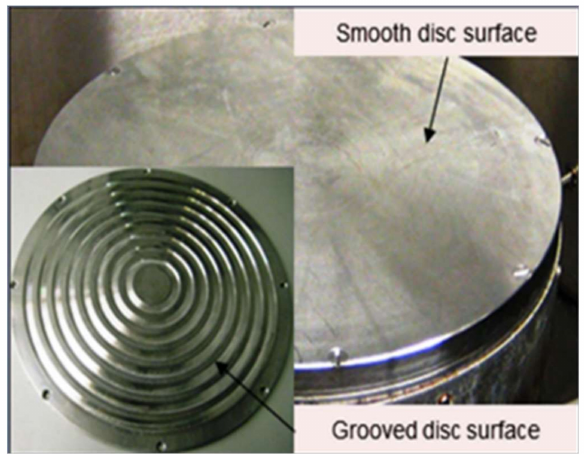
Figure 3. Grooved and smooth disc surfaces. Reproduced from [28], De Gruyter, 2019.